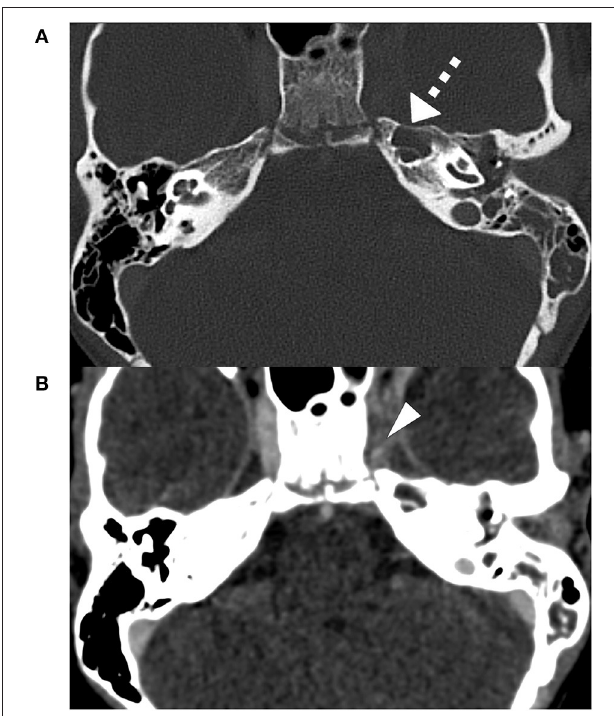
FIGURE 1 | Initial contrast-enhanced CT-Scan bone window, slice thickness 0.75 mm: partially obstructed mastoid air cells with a fully opacified, pneumatized petrous apex (triangle) on the left side (A) . Initial contrast-enhanced CT-Scan soft tissue window, slice thickness 0.75 mm: Obstruction of the left cavernous sinus (dashed arrow), suspicious of cavernous sinus thrombosis (B) .